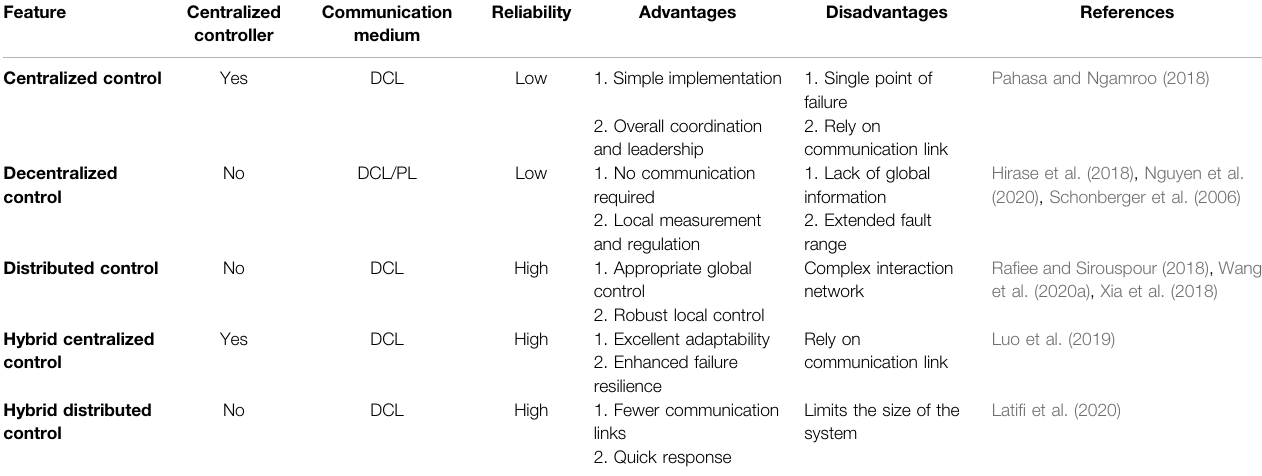
TABLE 3 | Comparisons of coordinated control